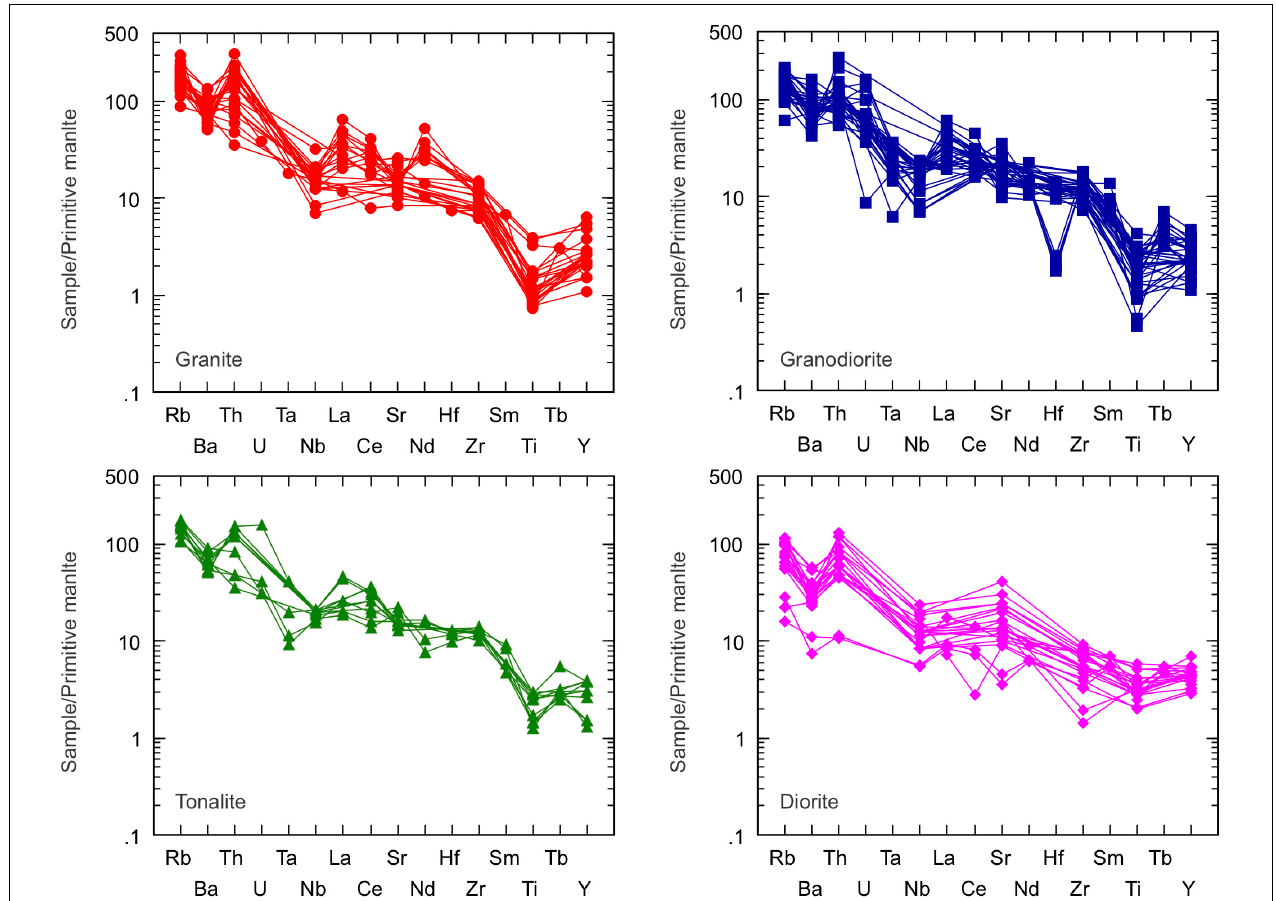
FIGURE 5 | Primitive mantle-normalized incompatible trace element diagrams of the Cretaceous (A) granites, (B) granodiorites, (C) tonalites, and (D) diorites from Kyushu. Normalizing values are from Sun and McDonough